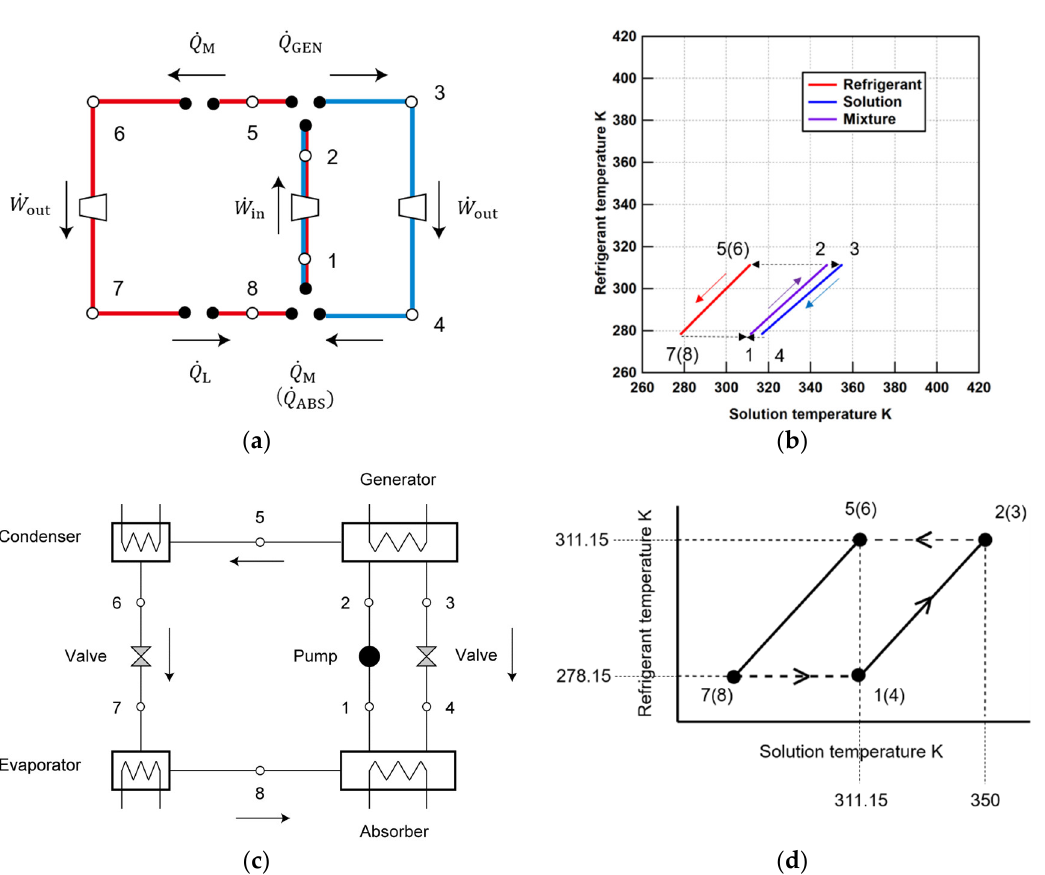
Figure 9. Optimal solution in case X (red line—refrigerant, blue line—absorbent solution): ( a ) Basic configuration calculated; ( b ) Operating properties calculated; ( c ) Cycle configuration of an existing single-effect absorption refrigerator; ( d ) Operating properties of an existing system. Table 2. Calculated values about the energy exchange rate in case X.